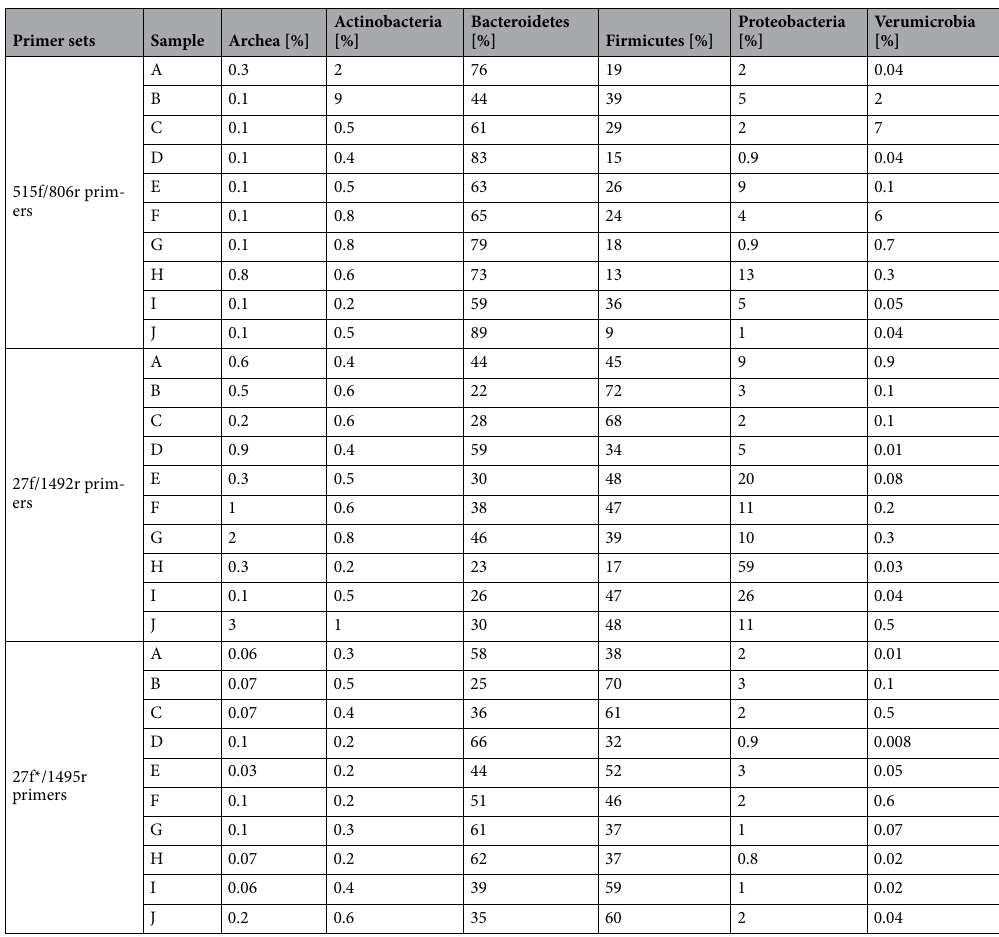
Table 3. Relative abundance of bacterial phyla in analysed